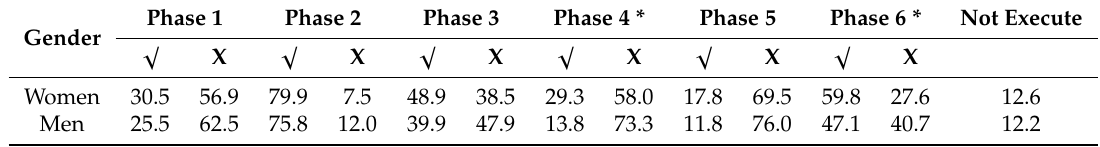
Table 7. Gender di ff erences in achievement level of handstand over eight academic